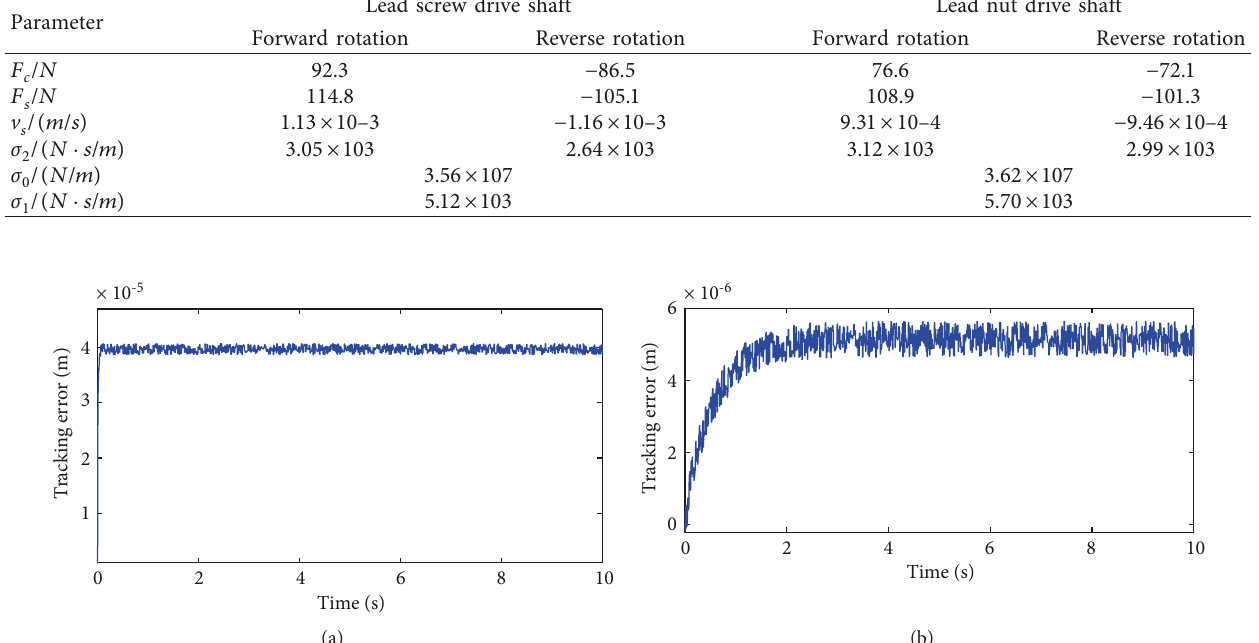
Figure 7: Ramp signal input tracking error curve. (a) Nonfriction compensated PID control tracking error curve. (b) Adaptive friction compensation control tracks the error curve.